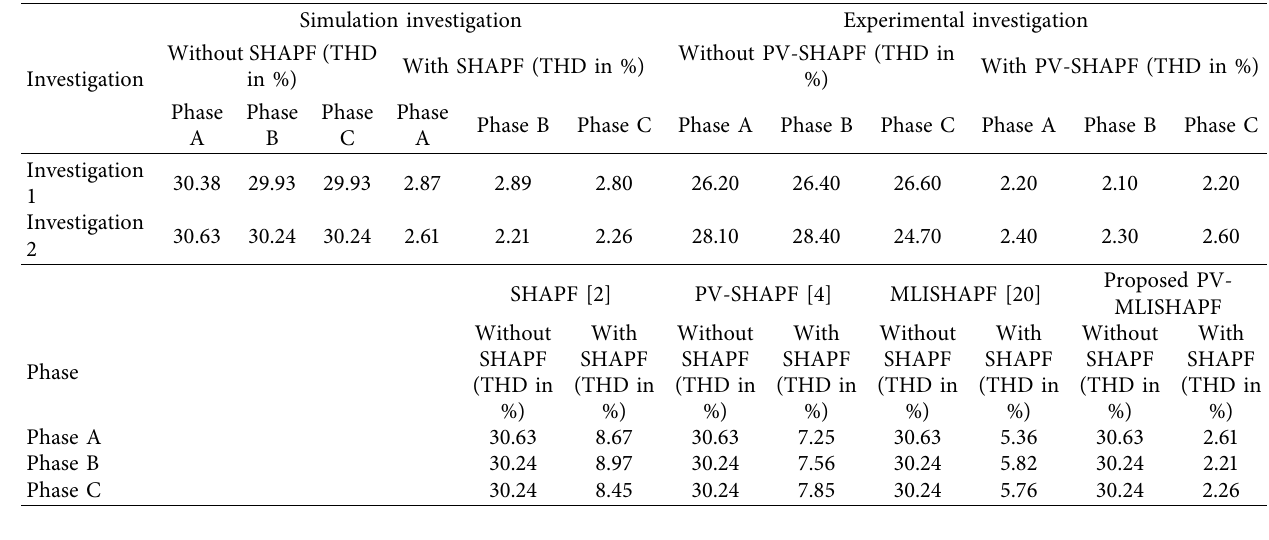
Figure 22: The THD spectrum of the source current before and after the hookup of the PV-SHAPF prototype mode. (a) THD of source current before the compensation. (b) THD of source current after the compensation. Table 3: Performance of the proposed MMPIFC boost converter-powered PV-SHAPF.